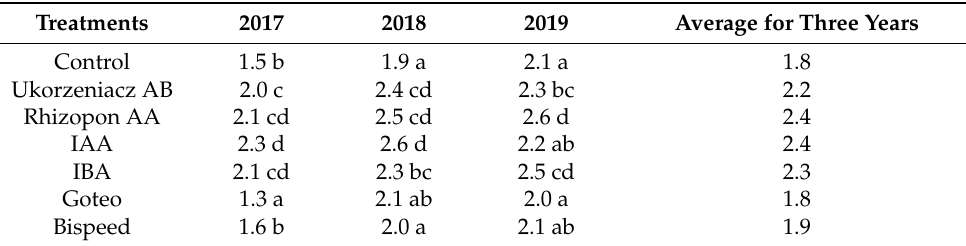
Table 3. Roots number of softwood cuttings of GiSelA 5 rootstock depending on the tested treatments in the years